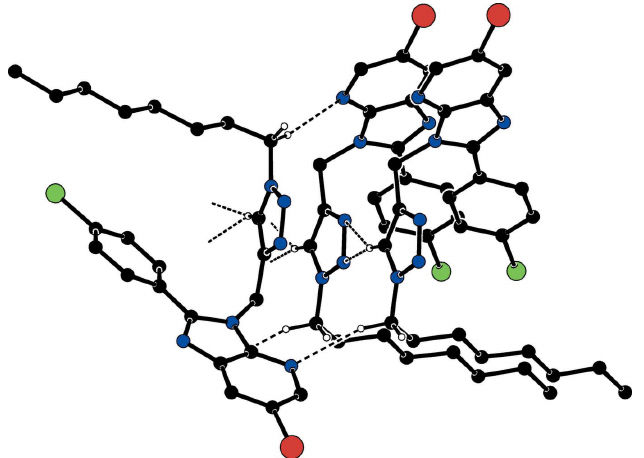
Figure 2 Detail of the crystal structure showing C—H (cid:3)(cid:3)(cid:3) N I and bifurcated C— H (cid:3)(cid:3)(cid:3) (N T ,N T ) (I = imidazo[4,5- b ]pyridine and T = triazole) hydrogen bonds, enclosing R 3